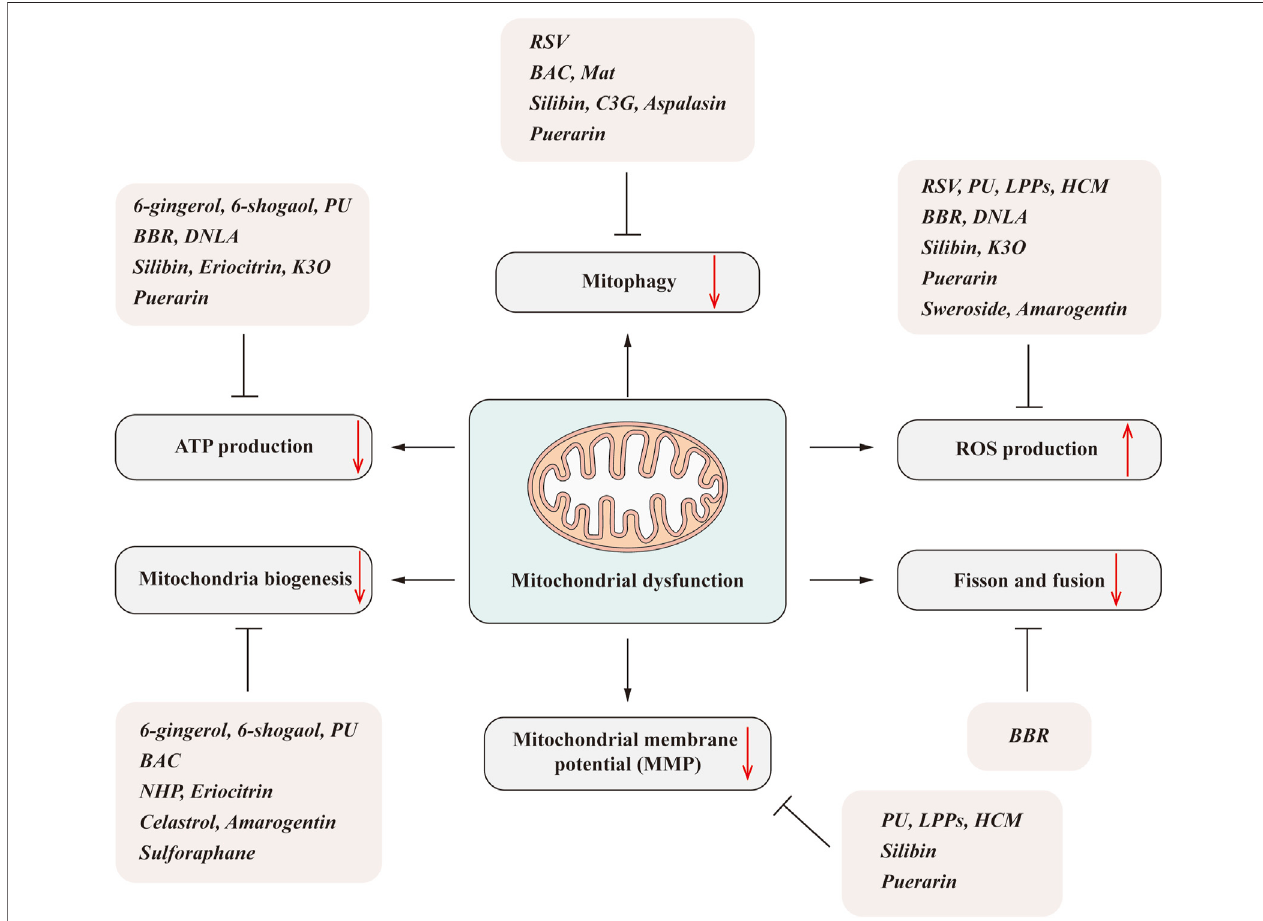
FIGURE2| NaturalproductsameliorateNAFLDbyregulatingmitochondrialdysfunction.Mitochondrialdysfunctionincludesmanyaspects,suchasthedecreased ATP generation, mitochondrial biogenesis reduction, impaired mitophagy, imbalanced fi ssion/fusion, and increased ROS production. The natural products, including phenols, alkaloids, fl avonoids, iso fl avones, and terpenoids, can signi fi cantly improve one or several aspects that linked to the mitochondrial dysfunction and subsequently improve the NAFLD.